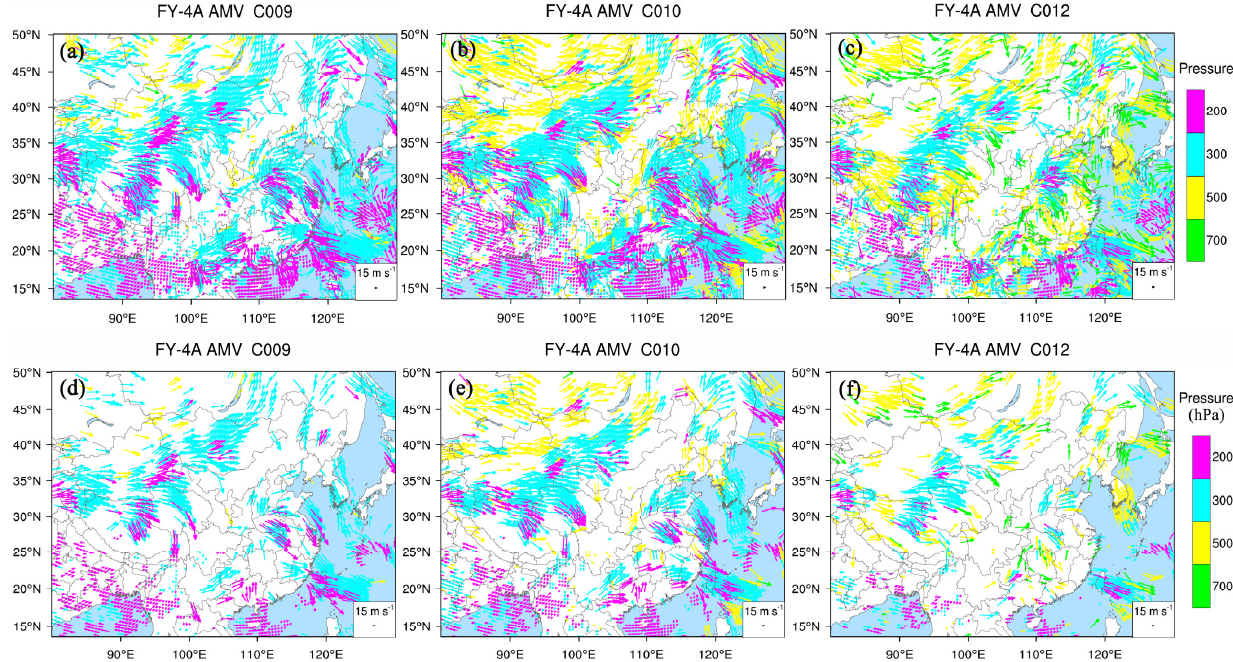
Figure 2. Spatial distribution of FY-4A AMVs over the grid points of the 9 km domain at 00 UTC 20 July 2021. ( a – c ) Spatial distribution of all AMVs from channels 9, 10 and 12, respectively. ( d – f ) Spa- tial distribution of the corresponding AMVs with the QI values above 80.